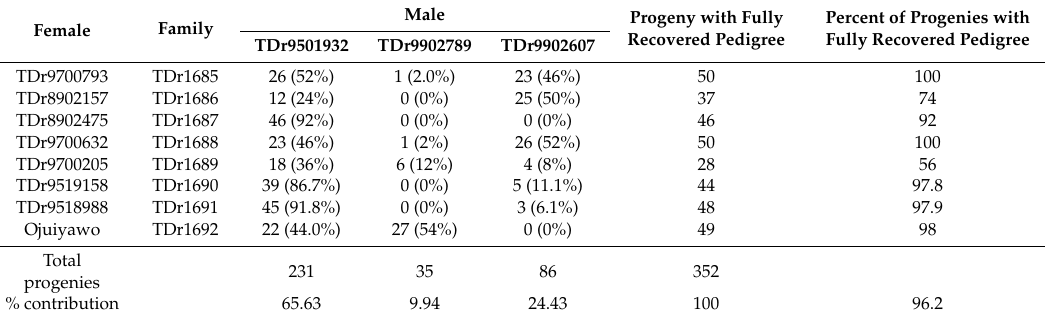
Table 2. The number and proportions of progenies with recovered paternal